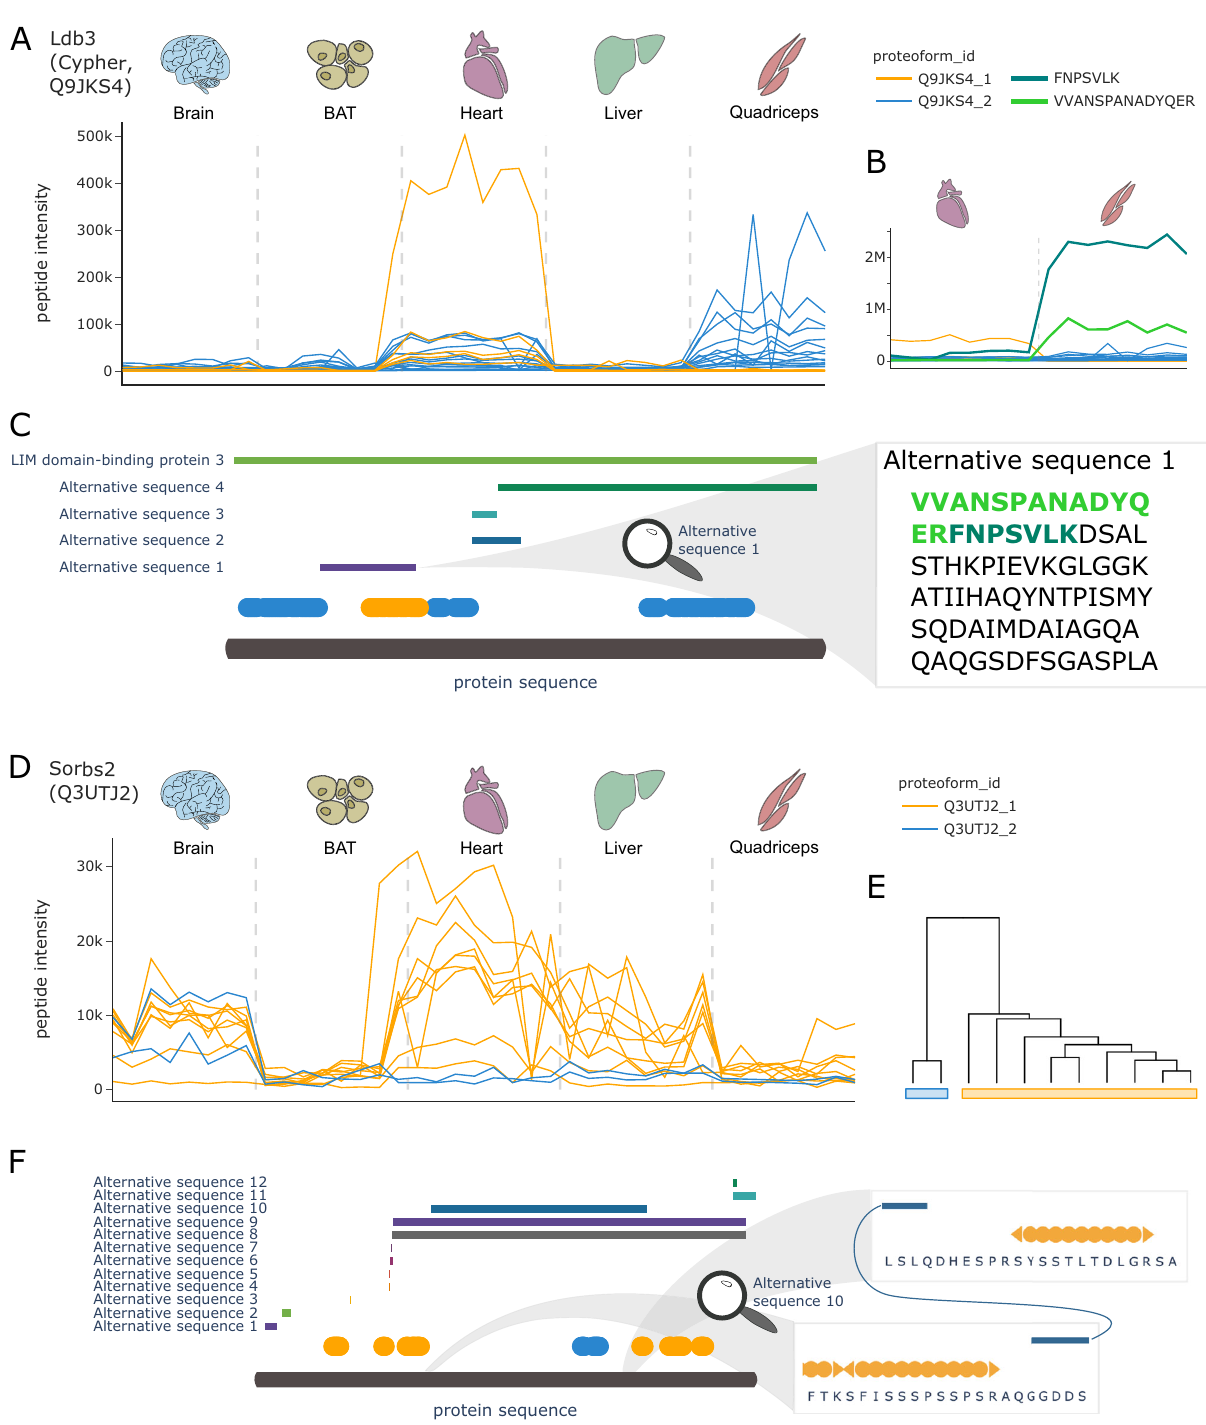
Fig. 7 COPF results for Ldb3 and Sorbs2. A Peptide pro fi les of the LIM domain-binding protein 3 (Ldb3, also known as Cypher, UniProt ID: Q9JKS4). Peptides of the two assigned proteoform groups are colored in orange and blue. B Zoom-in on muscle tissue, speci fi cally highlighting two additionally extracted peptides VVANSPANADYQER (light green) and FNPSCLK (dark green) that are speci fi c to the known skeletal muscle-speci fi c splice isoform of Ldb3. Please note that the abundance values between the orange and blue peptides cannot be directly compared to the additionally extracted peptides in green because of the separate analysis platforms used. C Protein sequence plot for Ldb3. Sequence coverage and position of the detected peptides of the two assigned proteoform groups are indicated in blue and orange. Chain information and alternative sequence isoforms from UniProt are indicated as horizontal bars. The zoom-in on alternative sequence 1 shows the sequence of the skeletal muscle-speci fi c splice isoform. The two peptides from B are highlighted in light and dark green, respectively. D Peptide pro fi les of the sorbin and SH3 domain-containing protein 2 (Sorbs2, UniProt ID: Q3UTJ2). Peptides of the two assigned proteoform groups are colored in orange and blue. E Clustering dendogram for Sorbs2. F Protein sequence plot for Sorbs2. Sequence coverage and position of the detected peptides of the two assigned proteoform groups are indicated in blue and orange. Alternative sequence isoforms from UniProt are indicated as horizontal bars. A zoom-in on the terminal regions of alternative sequence 10 shows that the orange proteoform does not cover this sequence